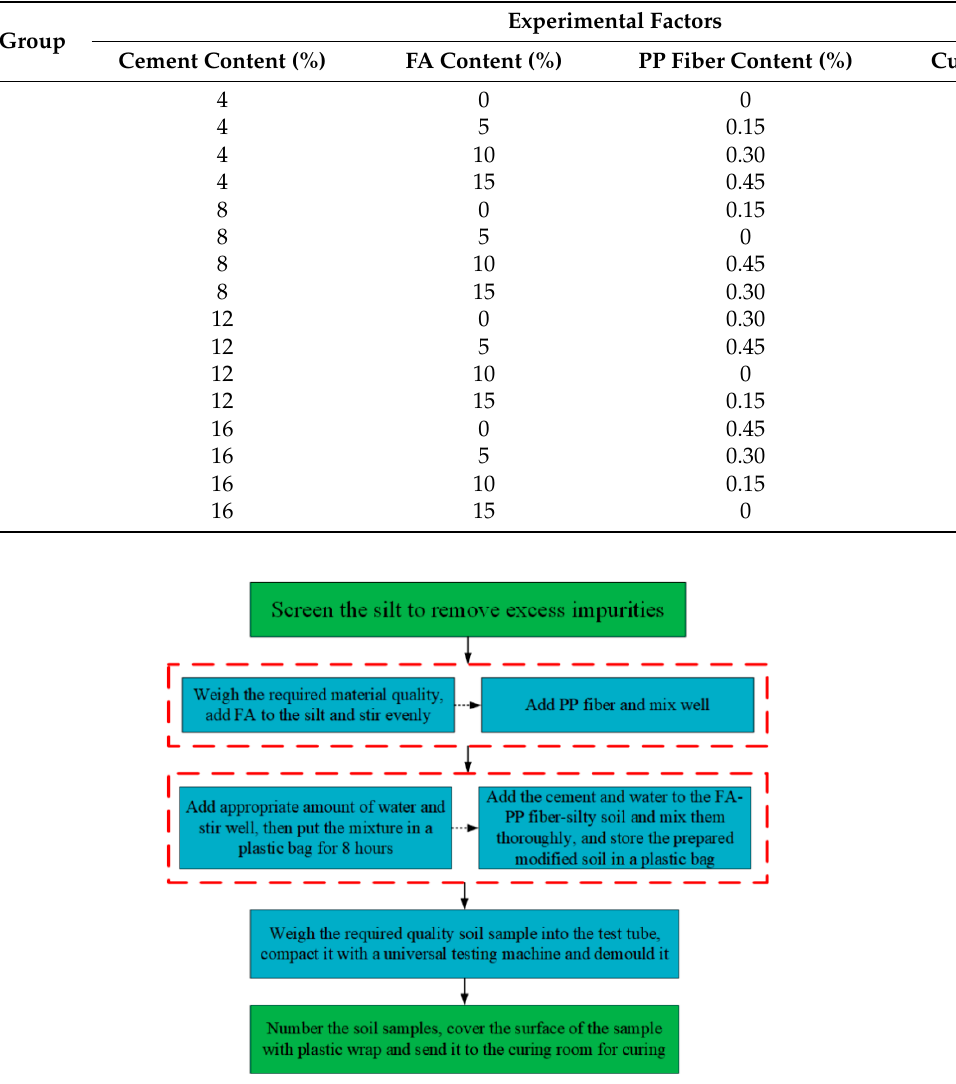
Table 2. Orthogonal test table.